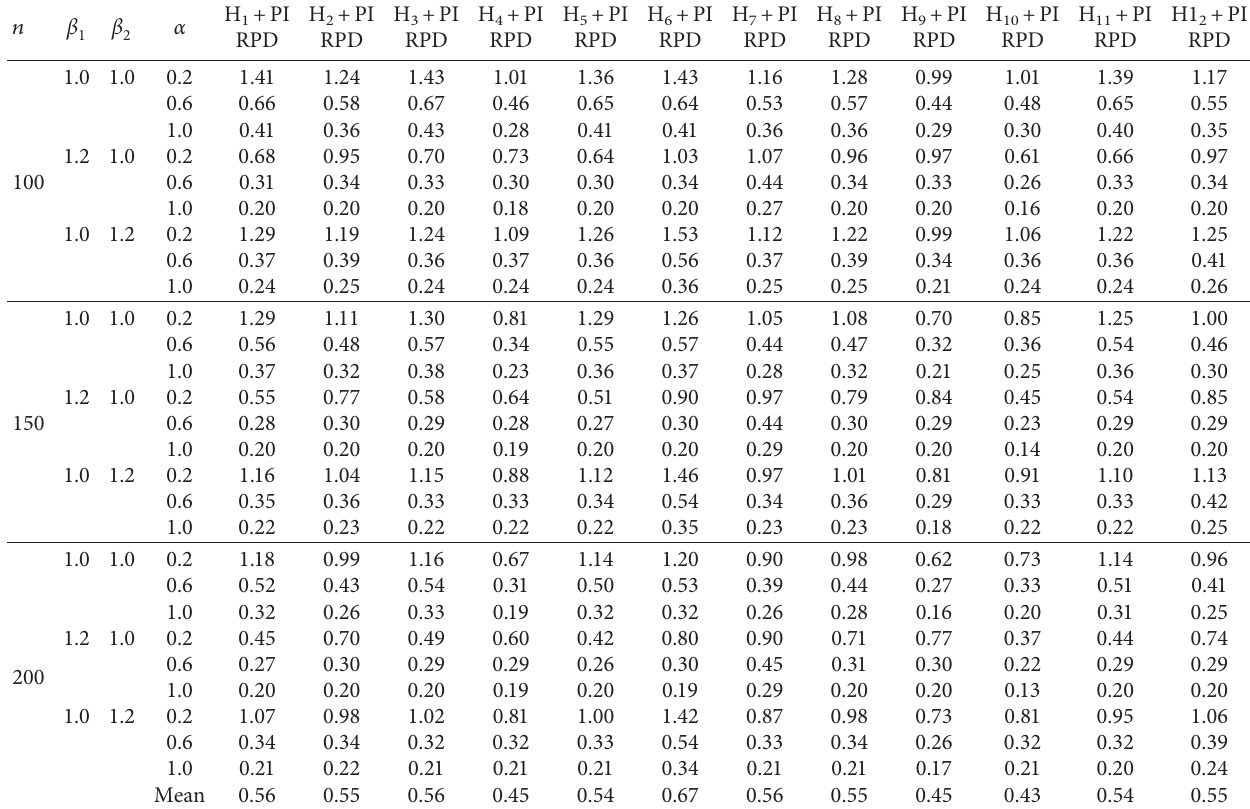
Table 4: The RPD of 12 Hi